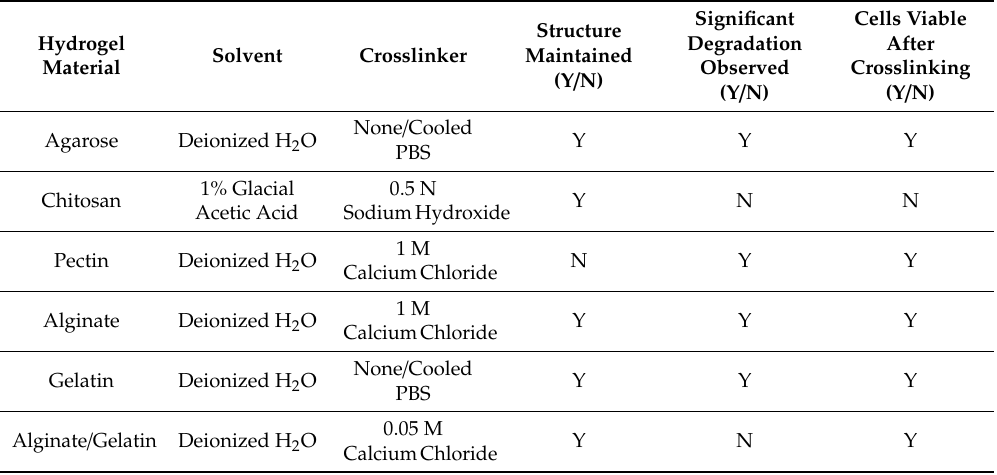
Figure 1. ( A ) Extrusion-based 3D printer modified and used for bioprinting applications. ( B ) AutoCAD design for 3D bioprinter. Cylinder sitting on x-axis design as printed. ( C ) Cylinder rotated 90 ◦ o ff the x-axis. ( D ) Basic settings calibrated for cell-laden 3D hydrogel bioprinting. Table 1. Materials screened for 3D hydrogel formation.